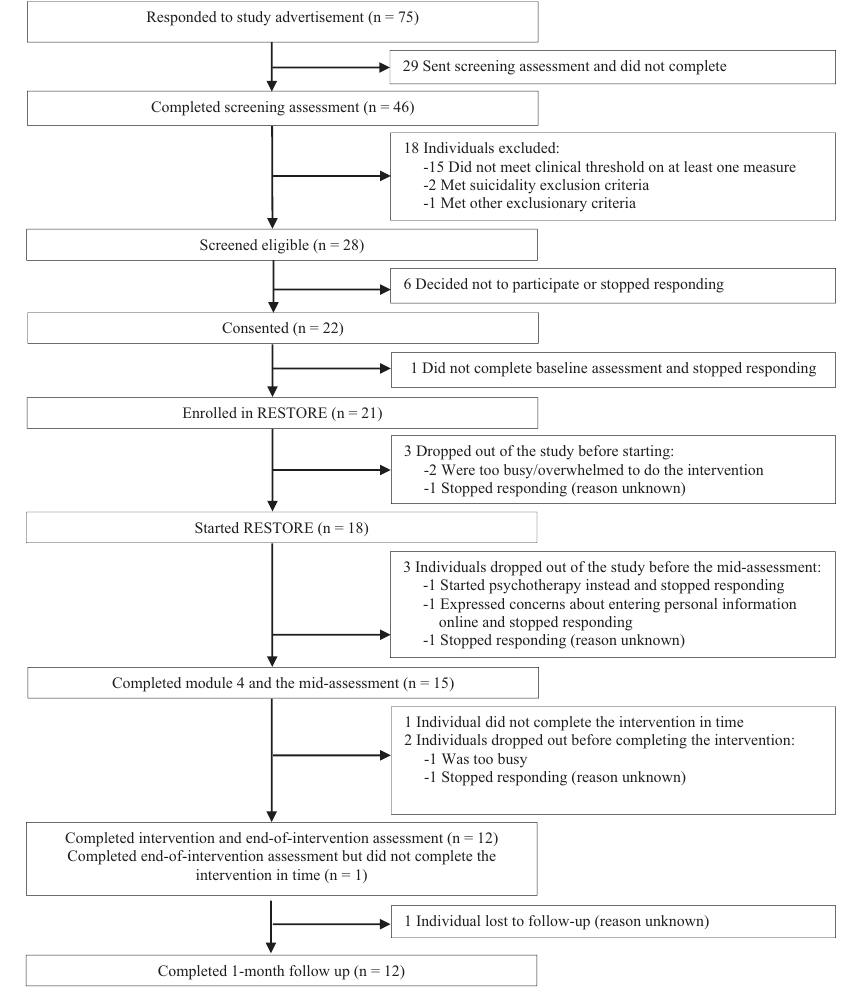
Fig. 1 Flow diagram of participants through the phases of study recruitment, assessment, and